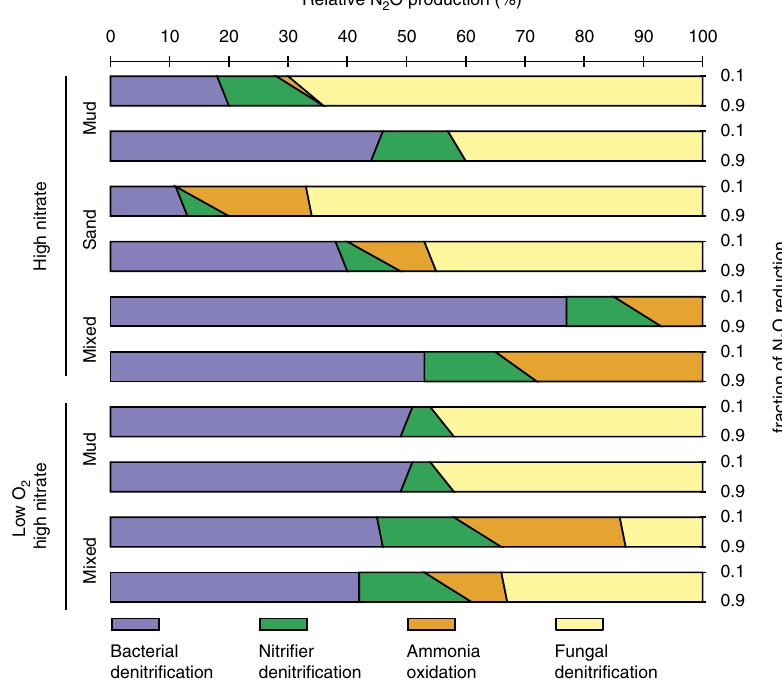
Figure 5 | Relative contribution of N 2 O produced by four cycling processes as calculated by N 2 O isotope mass balance. Each bar reflects steady-state calculations using measurements from a single core incubation (two cores were incubated per site per treatment and are shown separately), considering bacterial denitrification, ammonia oxidation, nitrifier denitrification and fungal denitrification. For illustration of the relative influence that N 2 O reduction (and its associated isotope fractionation) plays in the mass balance estimates, scenarios of both low (10%, upper) and high (90%, lower) relative N 2 O consumption are considered for each core (right side axis). Contribution by processes where mass balance estimates yielded small negative values (Supplementary Table 4) were considered equal to zero for this figure, with other values weighted accordingly to sum to 100%. The reader is also referred to Supplementary Table 4 for associated error in mass balance estimates calculated by Monte Carlo simulation, as well as Supplementary Tables 5 and 6 for sensitivity analyses of alternative endmember